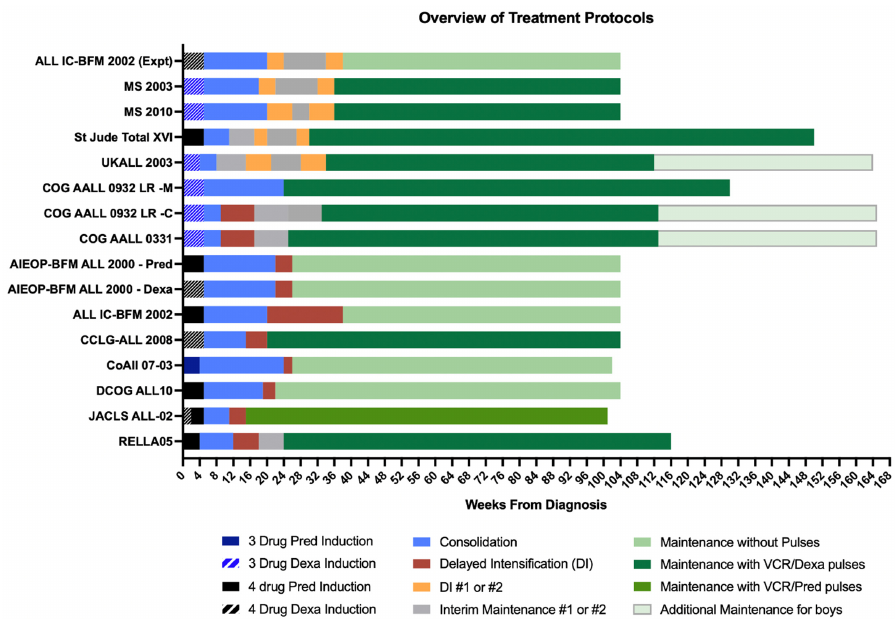
Figure 3. Overview of contemporary ALL protocols for lower − risk ALL: Major differences in protocol design of delayed intensification (single versus double blocks interspersed with interim maintenance blocks), types of maintenance phases are highlighted. Consolidation phases described in this figure refer to the period following the completion of induction phase and end prior to the start of delayed intensification phase and therefore include HD MTX phases. The experimental arm of the ALL IC-BFM 2002 study [16] comprised two shorter DI blocks (Protocol III), split from the original single Protocol II DI. MS2003 [18] and MS2010 [19] studies employed a similar dosing strategy with multiple DI blocks with improvements in toxicity following dosing modifications. The St Jude Total XVI [26] protocol embeds dual 3 week blocks of DI in interim maintenance phases which start right after the consolidation phase. Similarly, the UKALL 2003